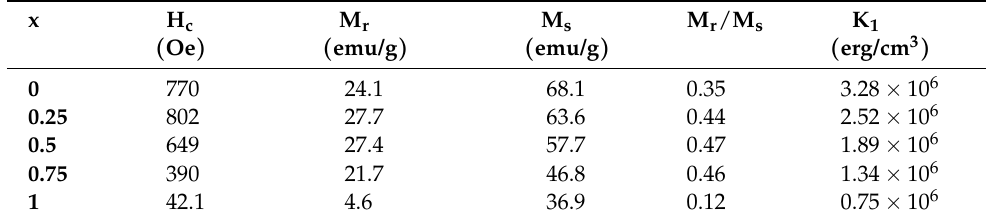
Table 3. H c , M r , M s , M r / M s , and K 1 of the Ni x Co 1 − x Fe 2 O 4 ferrites with 0 ≤ x ≤ 1 measured at 300 K. The description of the parameters is given in the